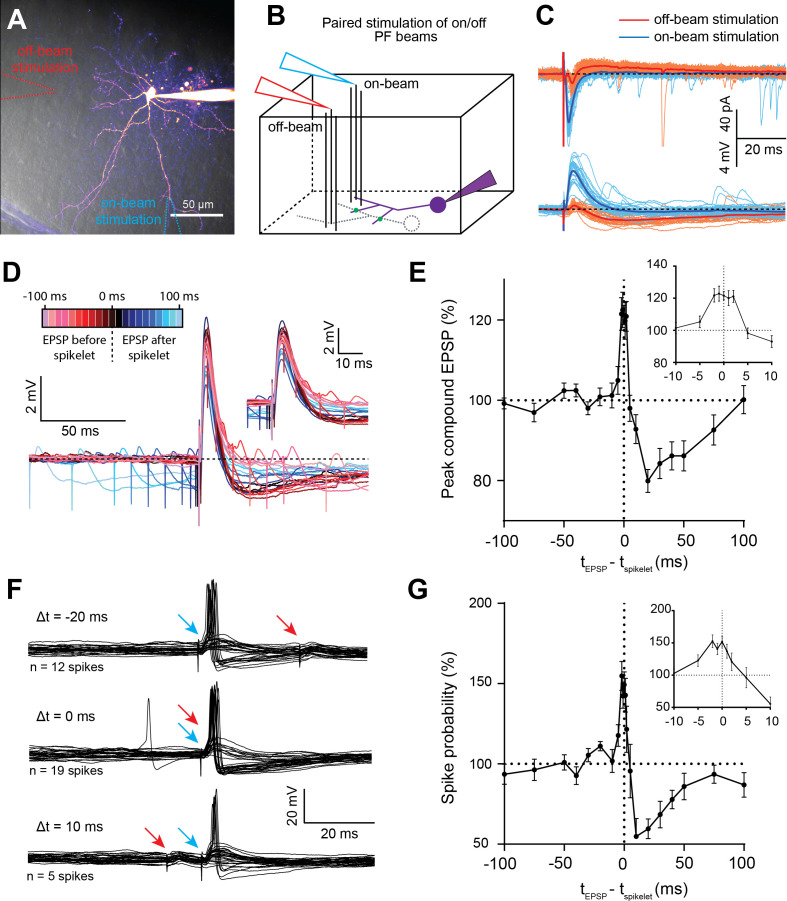
Spikelet transmission enables temporal contrast enhancement of basket cell (BC) excitation.(A) 2PLSM image (maximal intensity projection) of a BC loaded with 20 µM Alexa 594. Dashed lines indicate the position of the stimulating pipettes on top of the slice (off-beam stimulation in red, on-beam stimulation in blue). (B) Parasagittal block diagram showing on- (blue) and off-beam (red) extracellular electrode stimulation. (C) Superimposed voltage-clamp recordings (upper panel) and corresponding current-clamp recordings (lower panel) of postsynaptic responses to on-beam stimulation (light blue), or off-beam stimulation to elicit a spikelet (orange). Dark blue and red traces represent the averages of 30 trials for on and off-beam stimulation, respectively. (D) Superimposed compound excitatory postsynaptic potentials (EPSPs) recorded in current clamp and for different time delays between on- and off- beam stimulation (each trace is an average of 25 to 30 trials). Time delays (Δt) are relative to on-beam stimulation times. Positive time delays (i.e., off-beam stimulation before on-beam stimulation) are shown in blue shades, coincident stimulations are shown in black, and negative time delays are shown in red shades. Inset is an expanded time scale. (E) Peak amplitude of the compound synaptic responses (normalized to the mean amplitude of the single EPSPs alone) versus the time delay between EPSP and spikelet recruitment (n = 12 cells). Inset is an expanded timescale around the peak and in units of milliseconds. (F) Single trial AP responses to different delays between on- and off-beam stimulation. Shown here are three representative cases: spikelet (red arrows) recruited 20 ms after EPSPs (blue arrows) (top panel), coincidentally with EPSPs (middle panel), or 10 ms before the EPSP (lower panel). In each instance, 30 sweeps are shown. (G) Summary plot of the probability of eliciting an AP by on-beam stimulation (normalized to the mean probability of AP firing by on-beam stimulation alone) versus the time delay between EPSP (on-beam stimulation) and spikelet recruitment (off-beam stimulation; n = 11 cells). Inset is an expanded timescale around the peak and in units of milliseconds. See also Figure 8—source data 1.